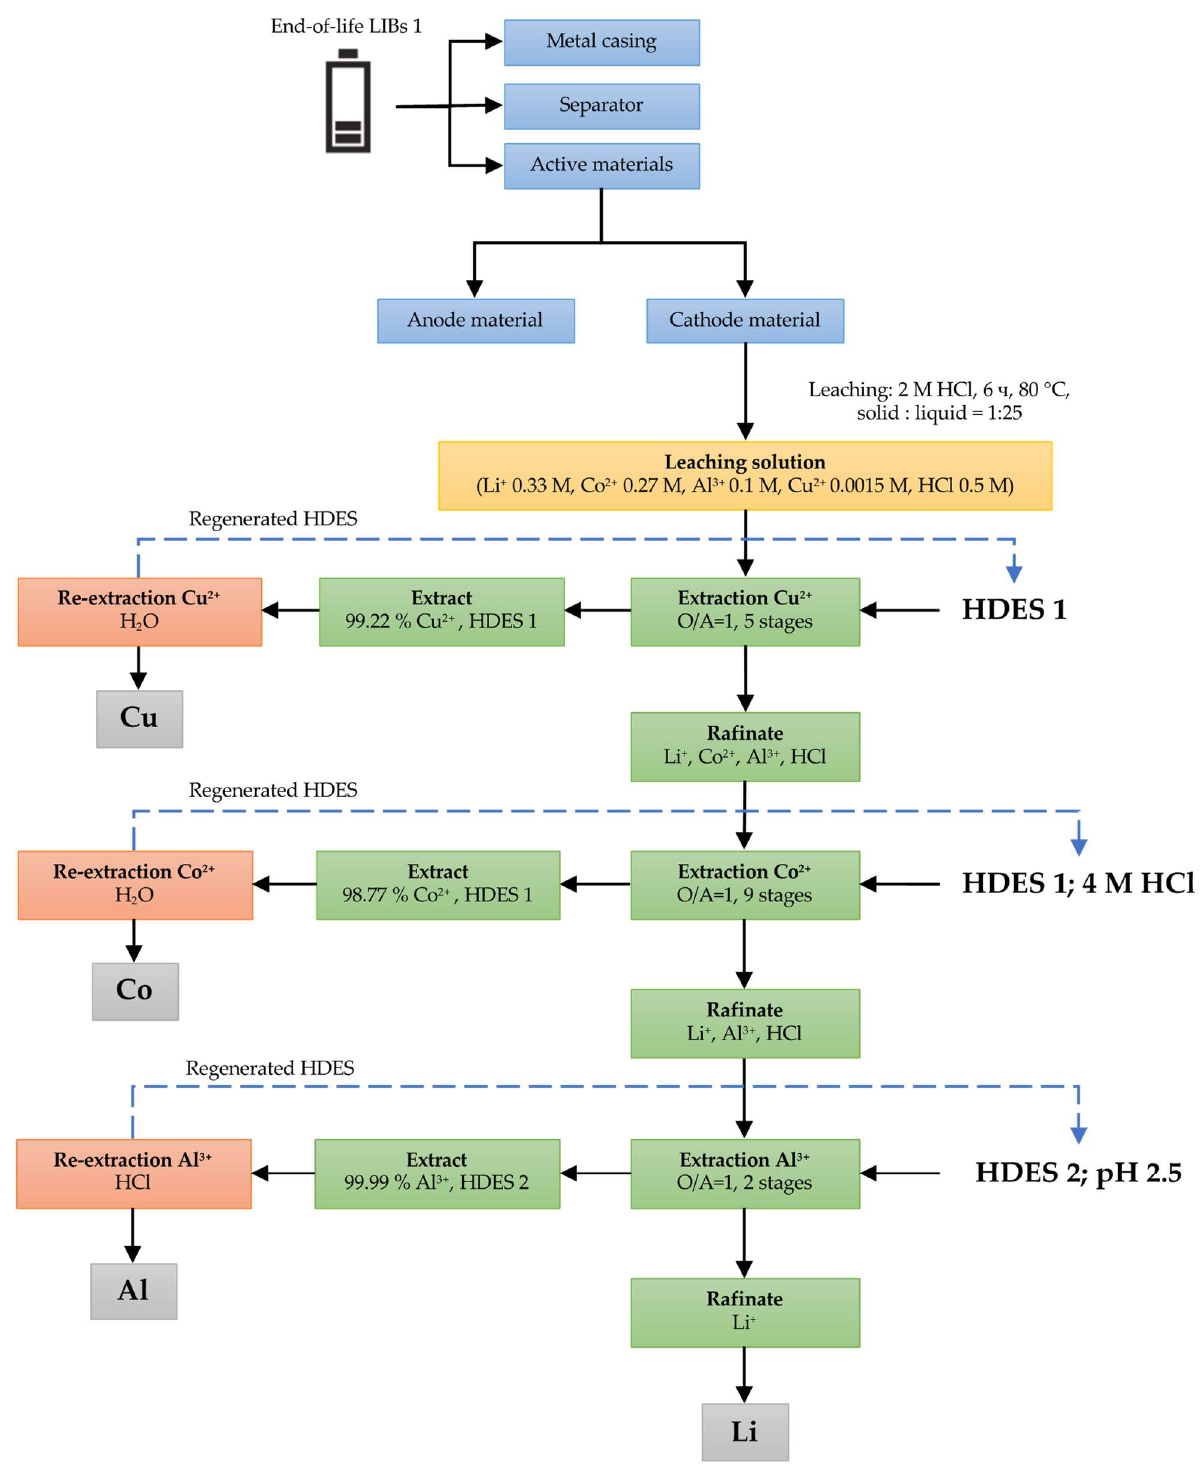
Figure 6. Scheme for the treatment of LIB 1 by leaching with hydrochloric acid and extraction with HDESs.